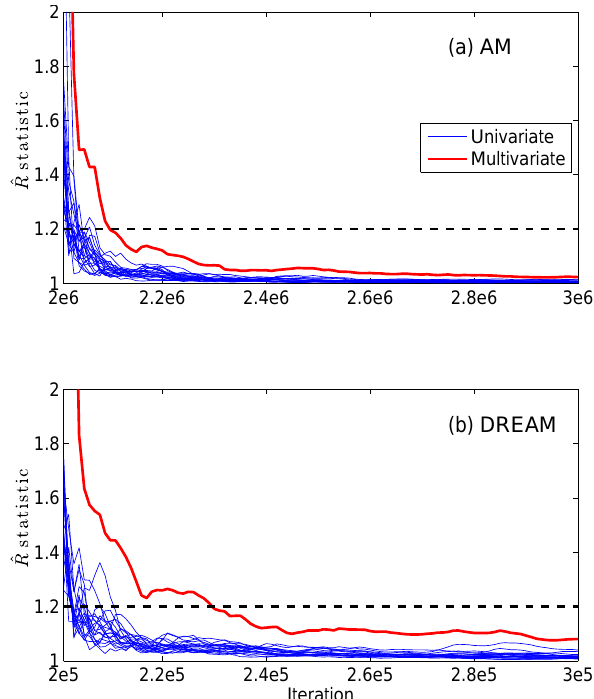
Figure 2. Univariate and multivariate Gelman–Rubin ˆ R statistics (a) for the last 1000000 iterations from 10 independent AM runs and (b) for the last 100000 iterations from the DREAM simulation using 10 interacting chains. The values less than the threshold of 1.2 suggest chain